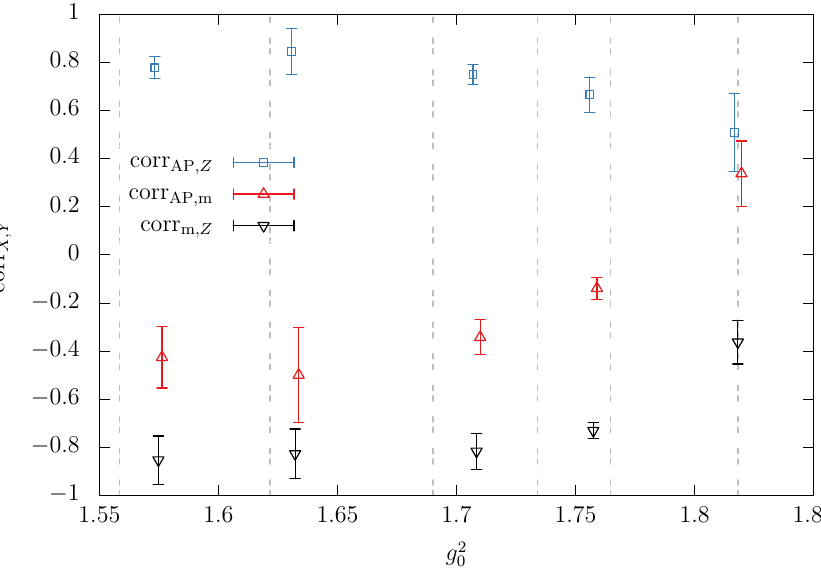
Fig. 11 Correlations between the estimators R AP , R m and R Z for the couplings used in our simulations. The points are slightly shifted for visibility. Vertical dashed lines indicate typical g 2 -values of CLS 0 large-scale simulations